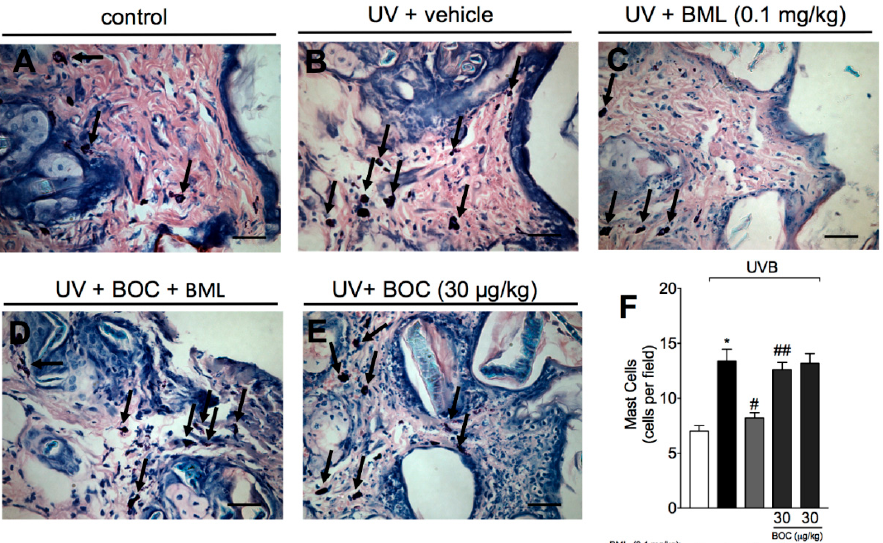
Figure 4. BML-111 reduces UVB irradiation-induced increase of mast cell count. Mast cells count was determined in samples dissected 12 h after the radiation and stained with toluidine blue. Representative images of non-irradiated control ( A ), irradiated treated with vehicle ( B ), irradiated treated with